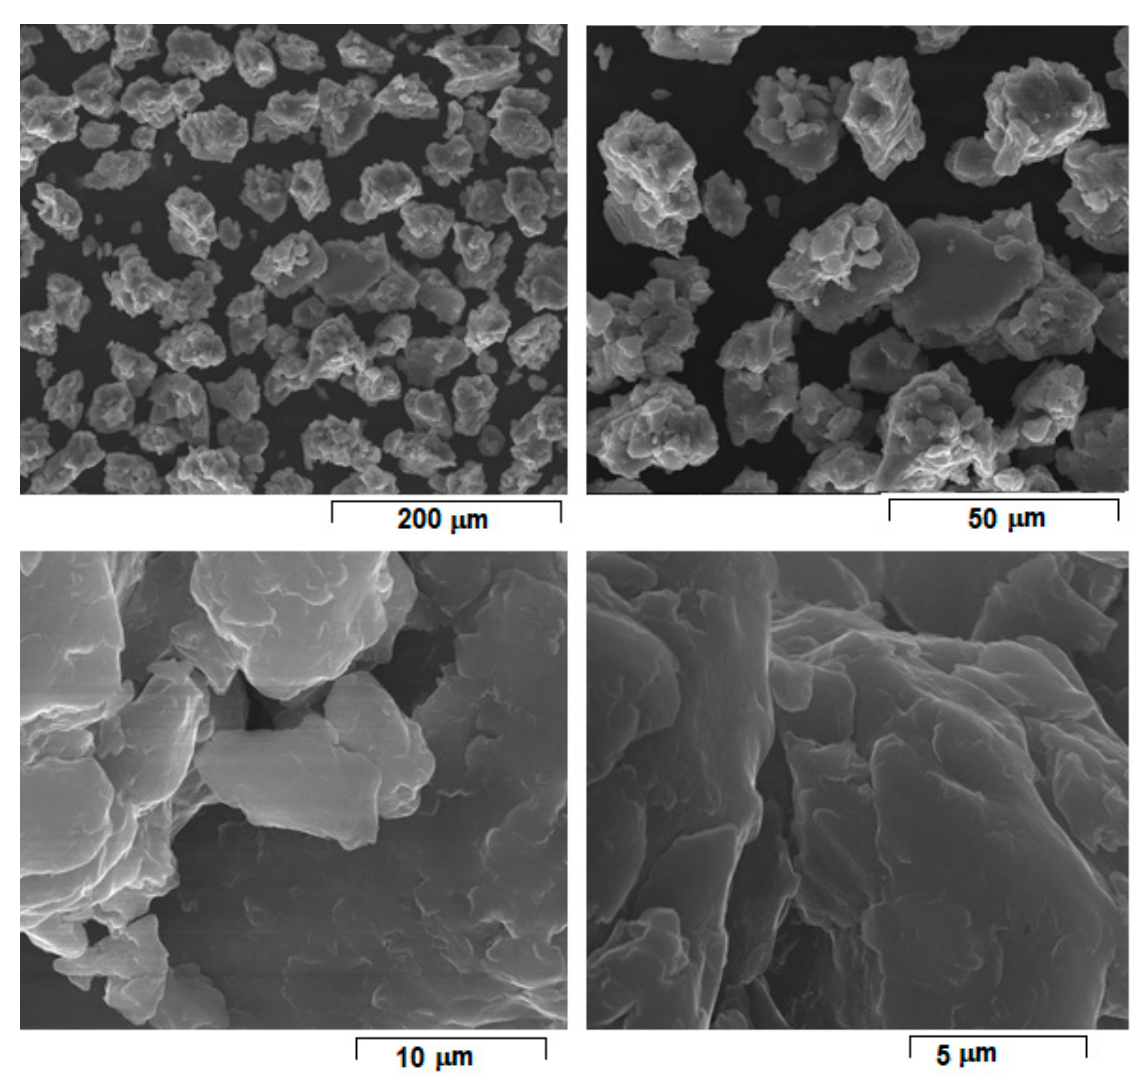
Figure 1. The SEM-SE images of the Mg-10Zn-0.8Ca-0.5Zr powder alloy obtained by mechanical alloying with 300 rpm/28 h/10:1 applied parameters and final sieving between 30–60 μ m; different magnifications.